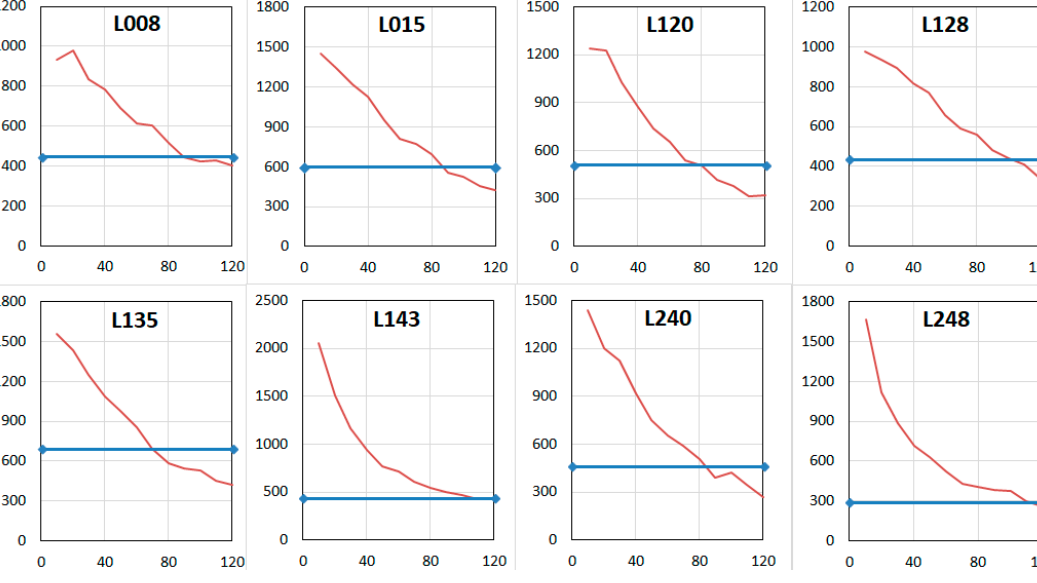
Figure 14. Variations of LBP feature vector components with lateral resolution in radial-uniform sampling. The x -axis gives the values of n u . The y -axis gives the range of values of an LBP feature shown in the chart title.